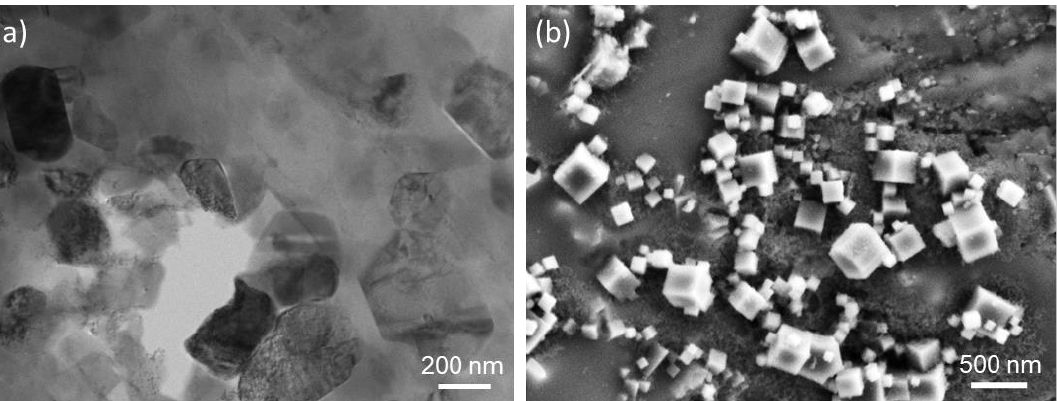
Figure 24. Faceted behaviour of the native MgO particles in Mg alloy melt [40,70,71]. TEM and SEM images showing ( a ) {1 1 1} faceted octahedral and ( b ) {1 0 0} faceted cubic MgO particles in Mg-9Al-1Zn (AZ91) alloy.